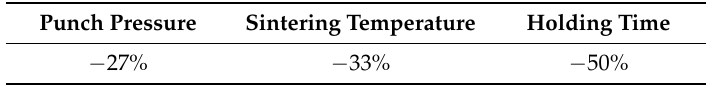
Table 2. Average ejection force reduction during the ejection as a function of the process parameters.